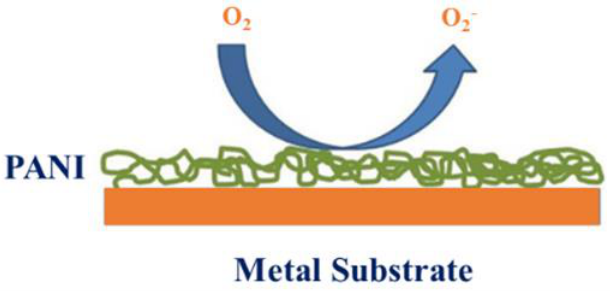
Figure 32. Mechanical image of the metal surface protected by PANI coatings against corrosion.